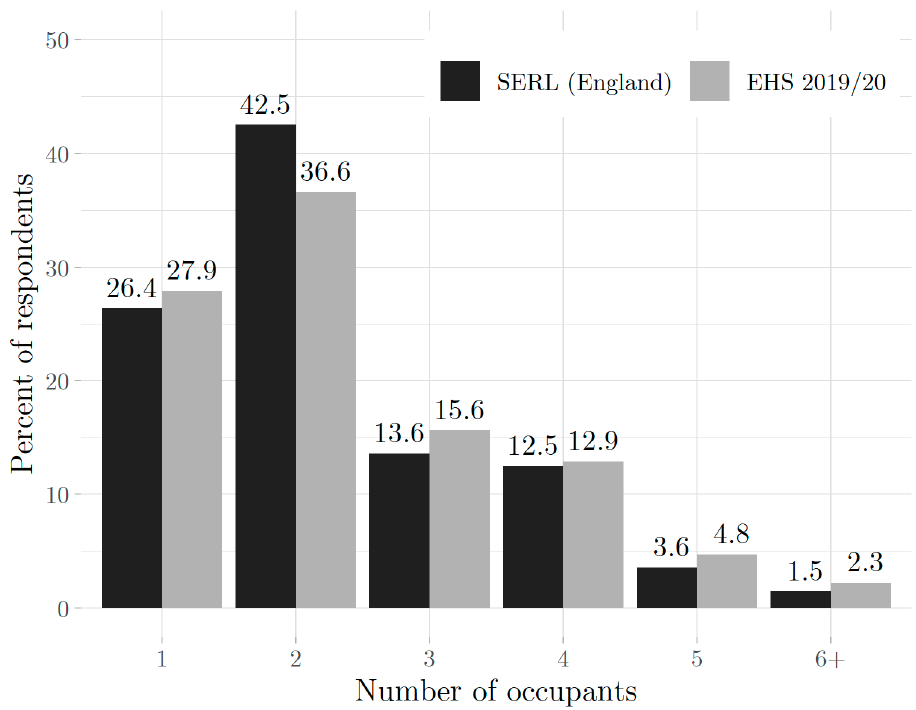
Figure 9. The number of occupants in SERL Observatory households in England (question C1) compared to EHS 2019/20 households.